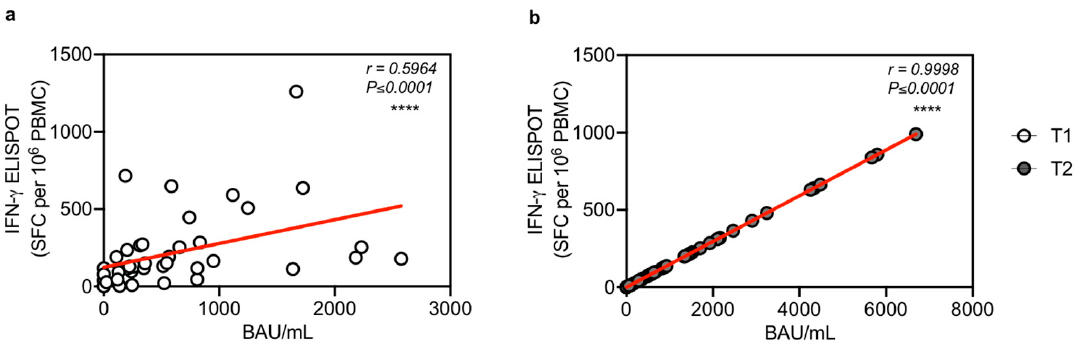
Figure 2. Correlation of IgG humoral responses against cellular immune response to SARS-CoV-2 vaccination in SOTRs (n = 43) after second (T1) and third (T2) dose of Pfizer-BioNTech BNT162b2 vaccine. ( a ) Correlation of T cell responses (IFN- γ ELISpot SFC per 10 6 PBMC) to Spike against anti-SARS-CoV-2 IgG (BAU/mL) at T1 (white dots). ( b ) Correlation of T cell responses (IFN- γ ELISpot SFC per 10 6 PBMC) to Spike against anti-SARS-CoV-2 IgG (BAU/mL) at T2 (grey dots). Spearman’s rank correlation (two-sided) was used to test the significance and the p -values and r-values (correlation coefficient) are indicated for each panel, **** p < 0.0001.